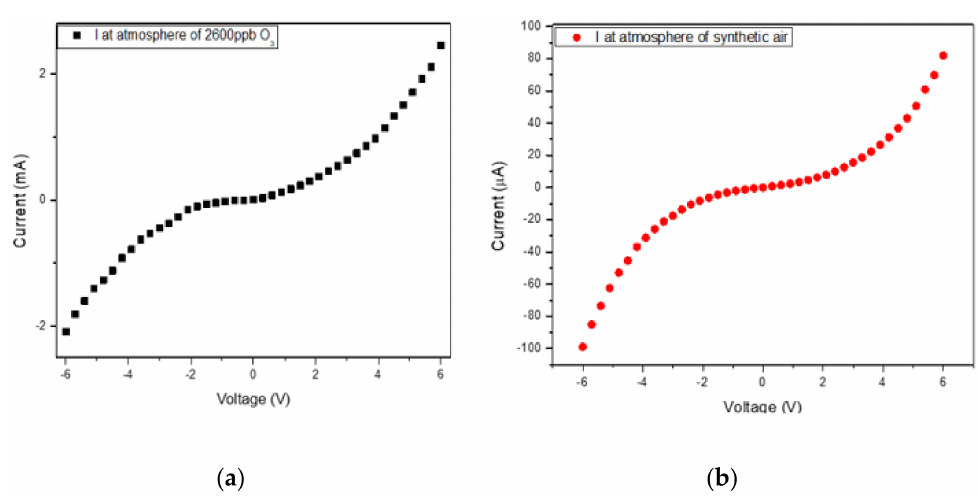
Figure 6. I-V curves of Co 3 O 4 film measured by the Lab setup under exposure to ( a ) 2600 ppb O 3 and ( b ) synthetic air atmosphere at room temperature.